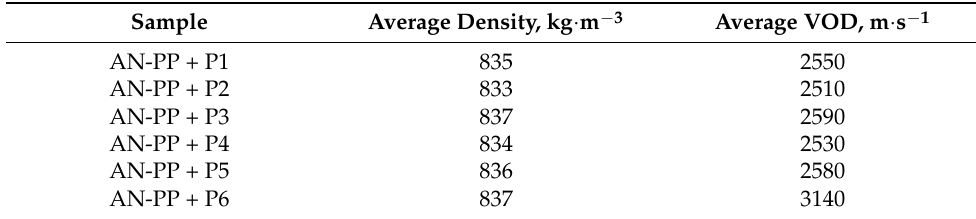
Table 5. Velocity of